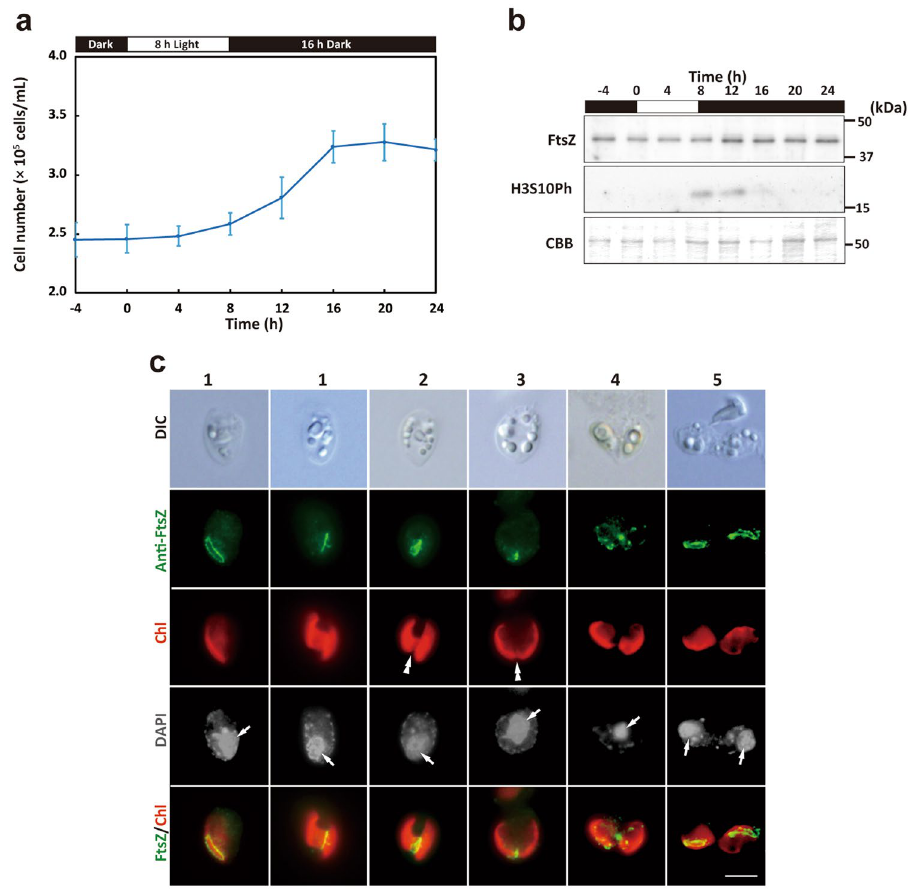
Figure 5. Change in the level and localization of nucleomorph-encoded FtsZ in the synchronous G . theta culture. ( a ) Change in the cell density in the culture synchronized by the 8-h light/16-h dark cycle. The error bar represents standard deviation of six technical replicates. ( b ) Immunoblot analysis showing the change in the FtsZ protein level and the level of histone H3 that is phosphorylated at serine 10 (H3S10ph) in the synchronous culture. Coomassie Brilliant Blue (CBB) staining is shown as the loading control. ( c ) Immunofluorescent micrographs showing the localization of FtsZ in the synchronized cells. DIC, images of differential interference contact; Anti-FtsZ, nucleomorph-encoded FtsZ detected with the antibody; Chl, chloroplast autofluorescence; DAPI, DNA stained with DAPI; FtsZ/Chl, merged images of Anti-FtsZ and Chl. The double arrowhead indicates constriction of the chloroplast division site. The arrow indicates DAPI signal of the nucleus. Scale bar = 5 µ